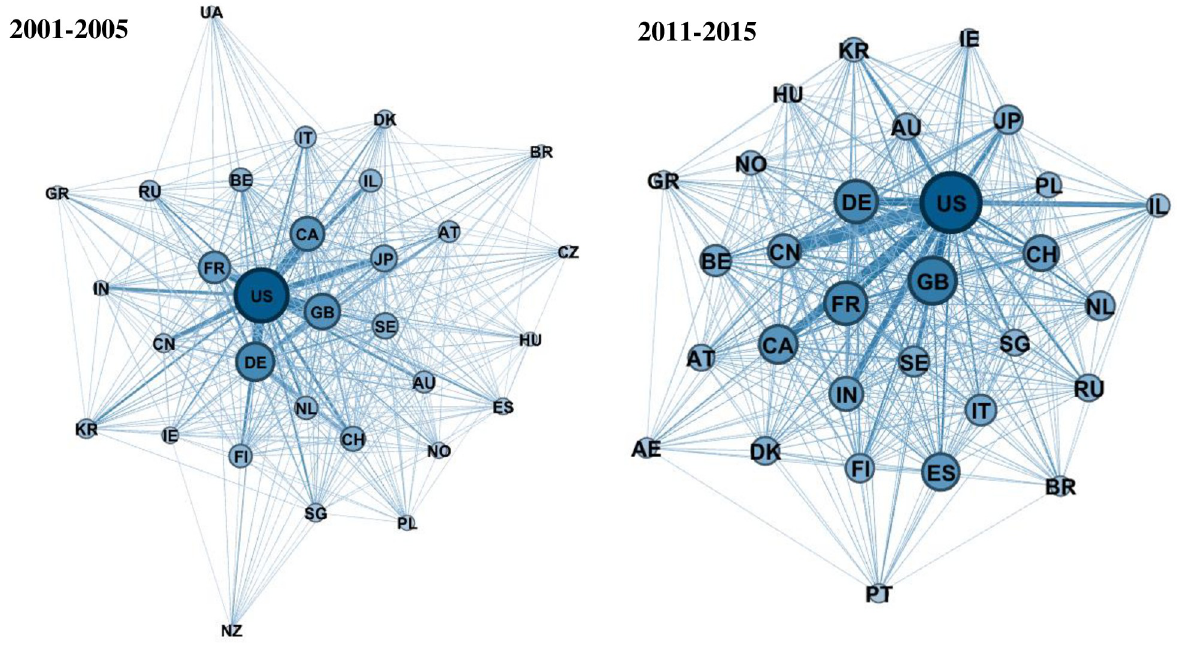
Fig 1. Global R&D collaboration network in ICT. Country codes given in S1